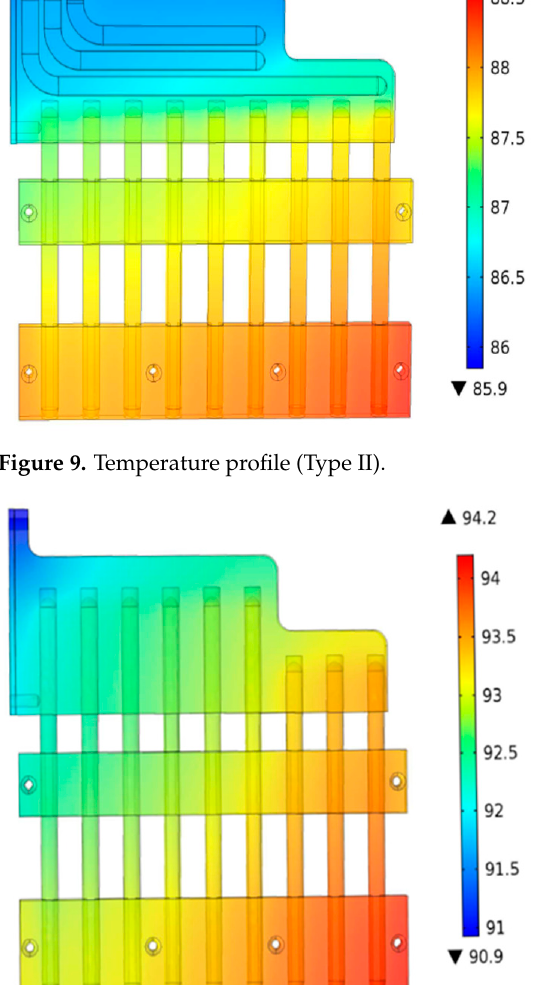
Figure 11. Temperature profile (Type IV). Table 2. A Comparison of High and Low Temperature Simulations. Type I